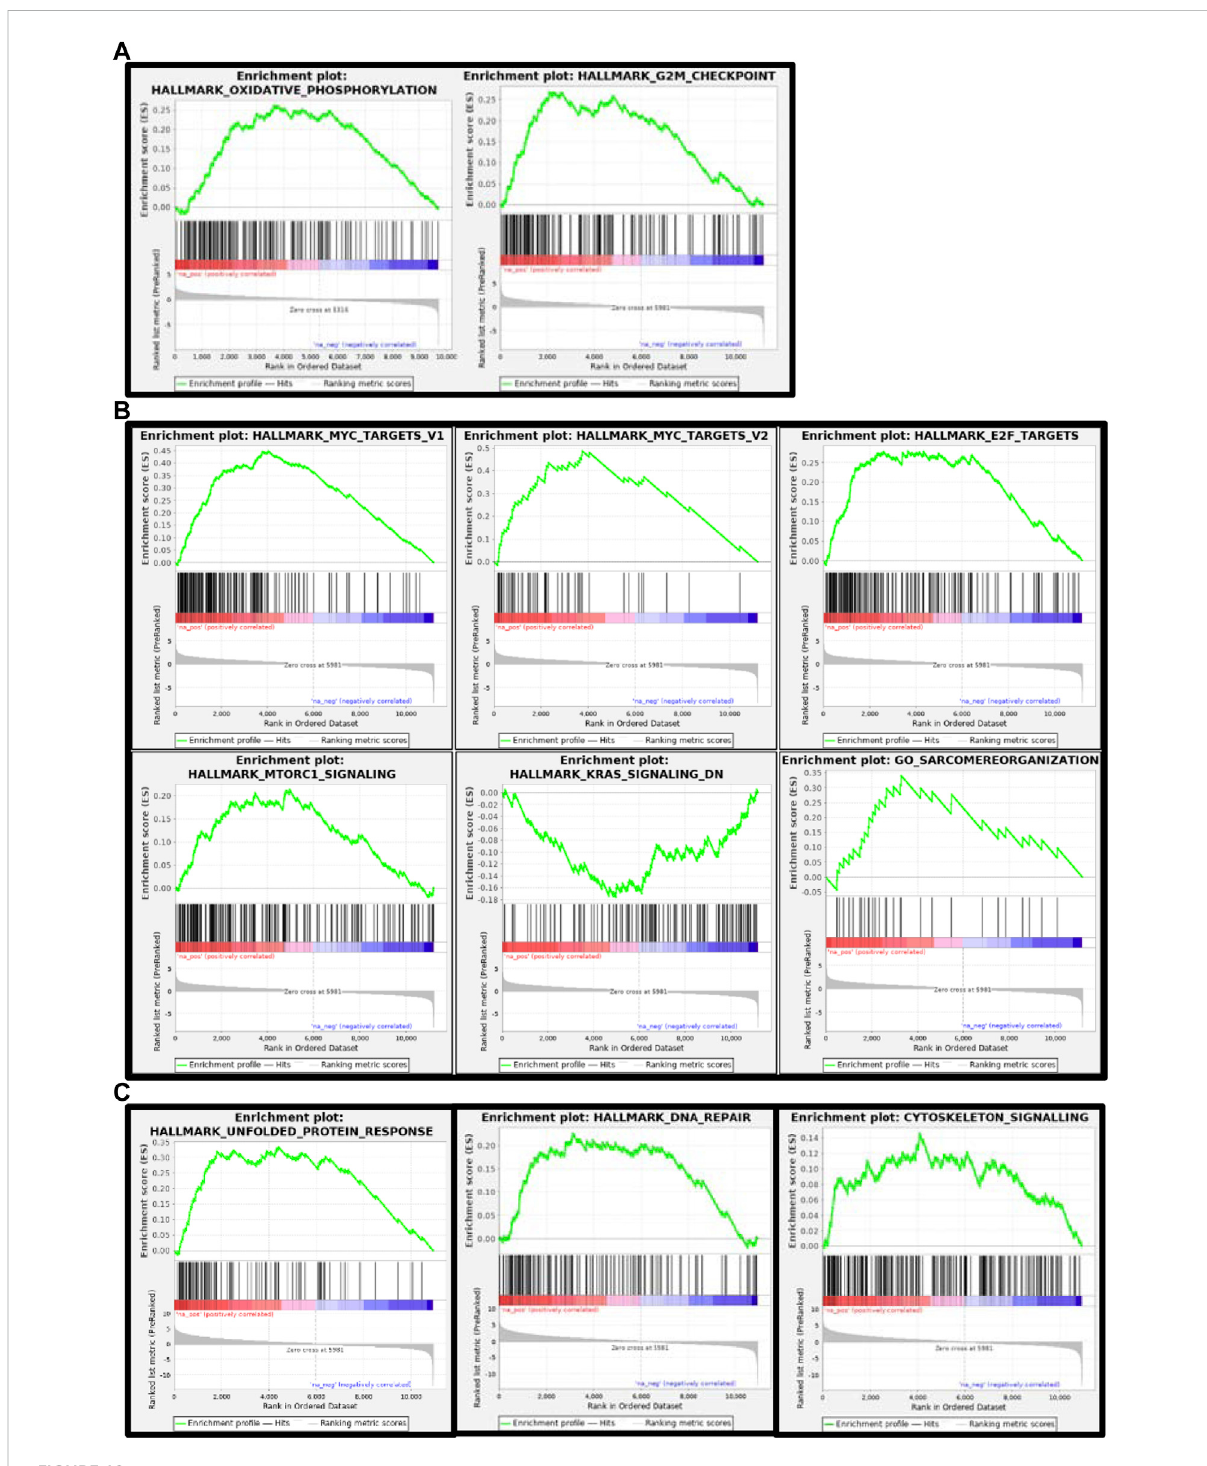
FIGURE 10 Gene set enrichment analysis (GSEA) plots of gne KO at 3 (A) , 5 (B) and 7 (C) dpf. GSEA plots show the enrichment score on the y axis for genes related to each gene set. Genes are ordered on the x axis according to their GSEA enrichment score. FDR adjusted p -value ( < 0.05).